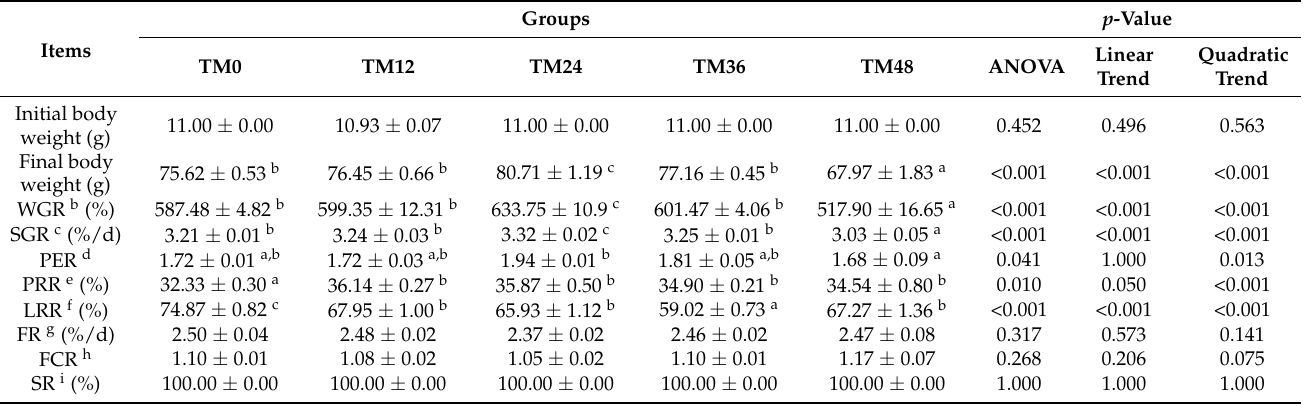
Table 6. Effects of fishmeal replacement with TM on the growth performance of Micropterus salmoides a